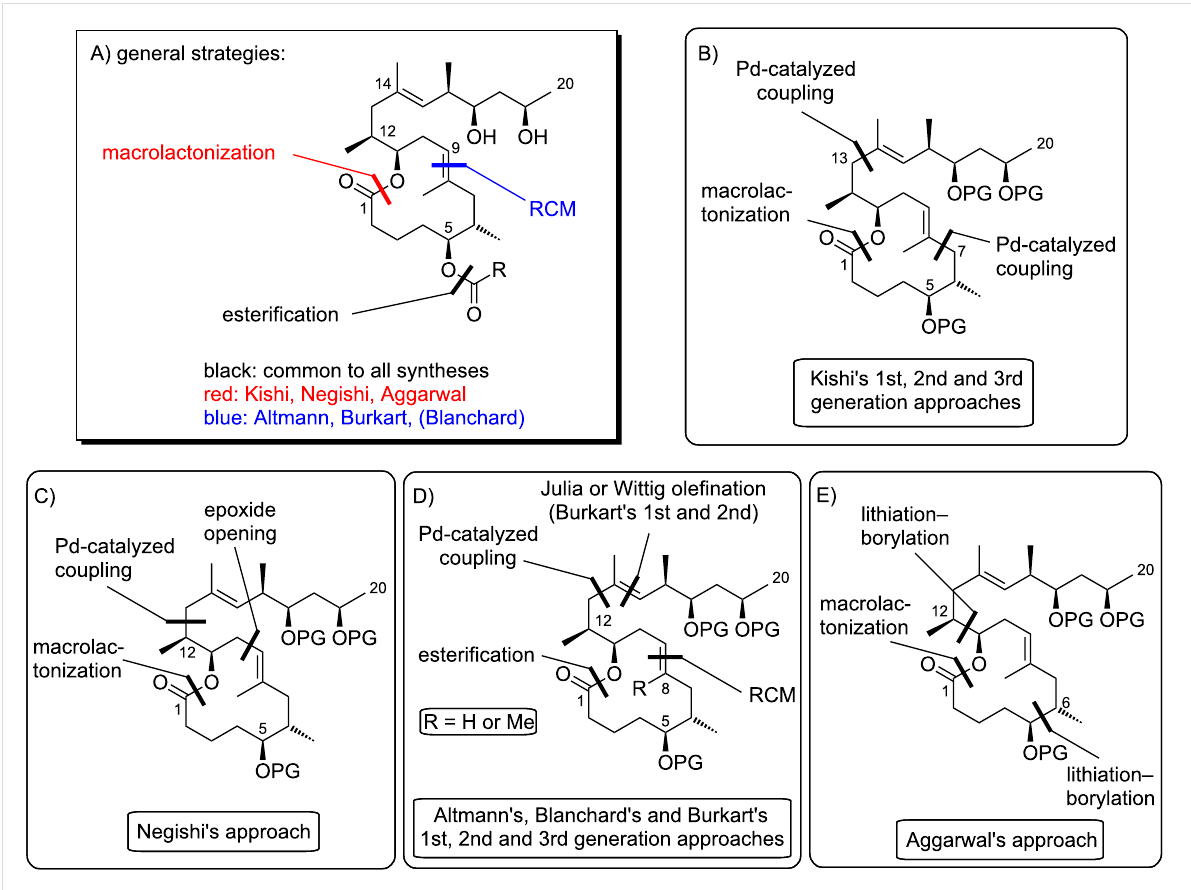
Figure 7: Synthetic strategies towards the extended mycolactone core. A) General strategies. B) Kishi’s approaches. C) Negishi’s approach. D) Altmann’s, Blanchard’s and Burkart’s approaches. E) Aggarwal’s approach. PG = protecting group.